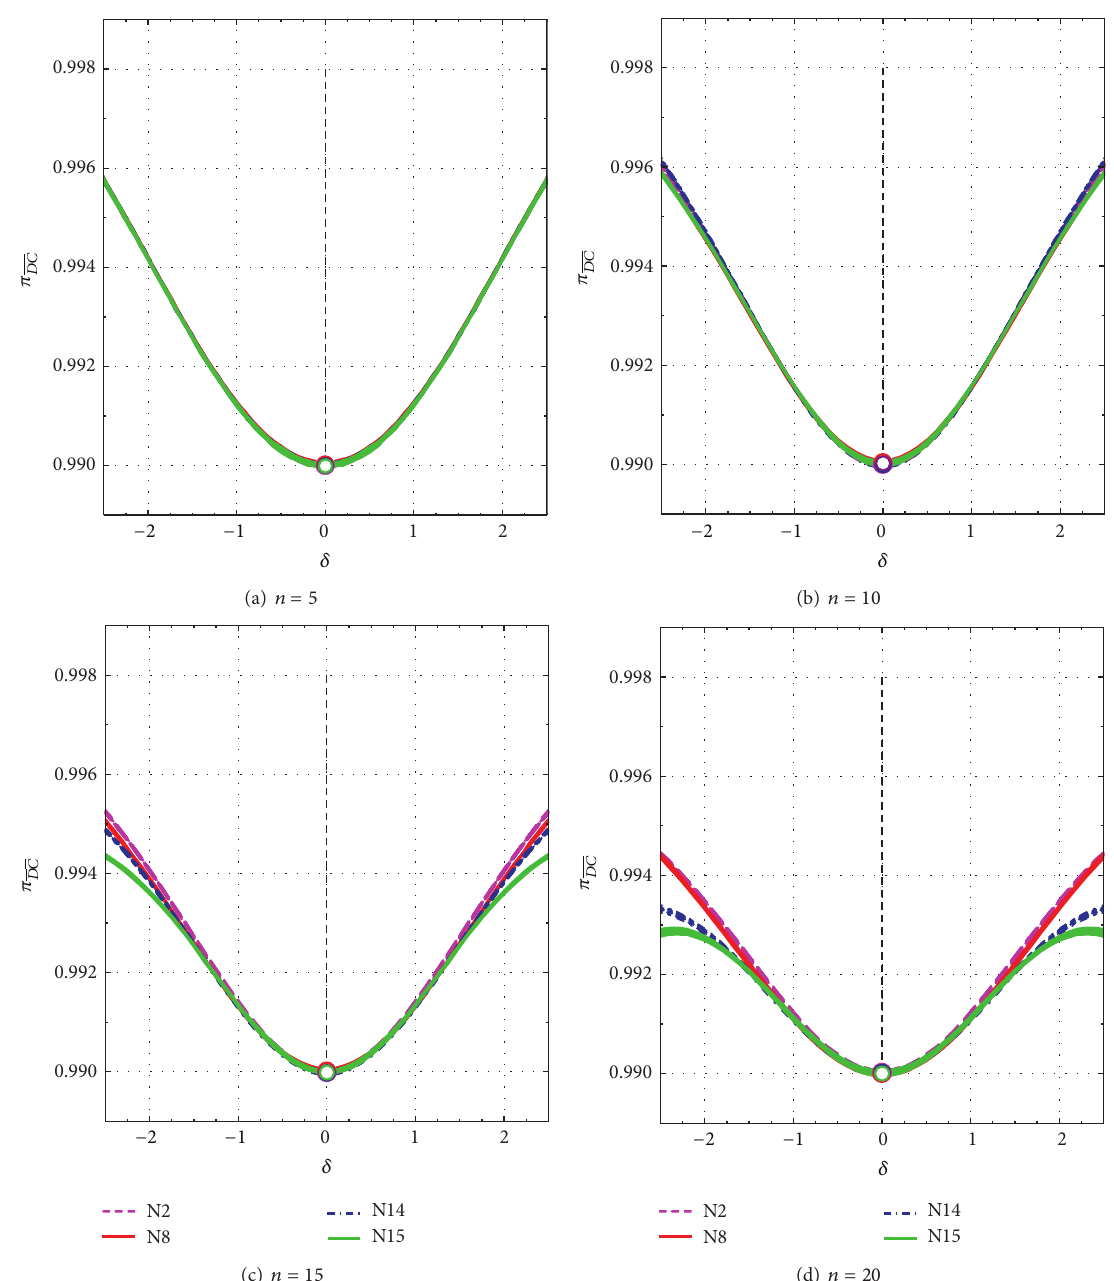
Figure 3: Spurious type II error probability ( 𝜋 𝐷𝐶 ) as a function of 𝛿 from − 2.5 to +2.5 for all tests N2, N8, N14, and N15. 𝜋 𝐷𝐶 values for uncontaminated samples ( 𝛿 = 0 ) are shown by open circles. (a) 𝑛 = 5 ; (b) 𝑛 = 10 ; (c) 𝑛 = 15 ; and (d) 𝑛 = 20 .